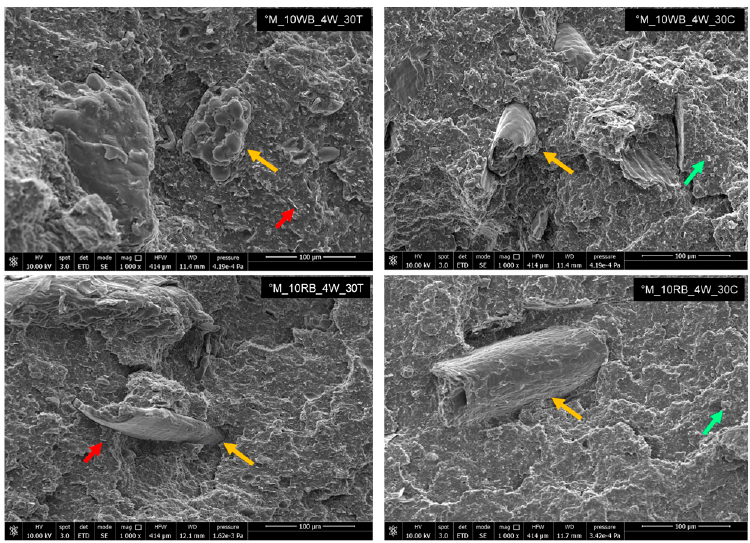
Figure 9. SEM micrographs with 1000× of magnification of optimized biocomposites with WB ( up ) and RB ( down ) with 30 wt.% of talc ( on the left ) and 30 wt.% of calcium carbonate ( on the right ). The red arrows highlight the lamellar nature of talc, which, despite being in very high quantity, is well distributed inside the PLA-PBSA matrix. Moreover, the uniform disper- sion of the quasi-spherical calcium carbonate particles (shown in Figure 9 with the green arrow) is evident. Consequently, the morphological features, seem in agreement with in- teraction parameter results and thermomechanical considerations.